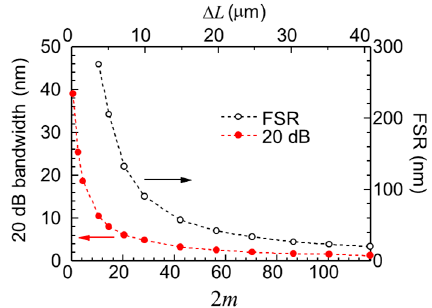
Figure 3. Free-spectral range (FSR) and 20-dB isolation bandwidth of an MZI isolator as a function of integer m of reciprocal phase bias.